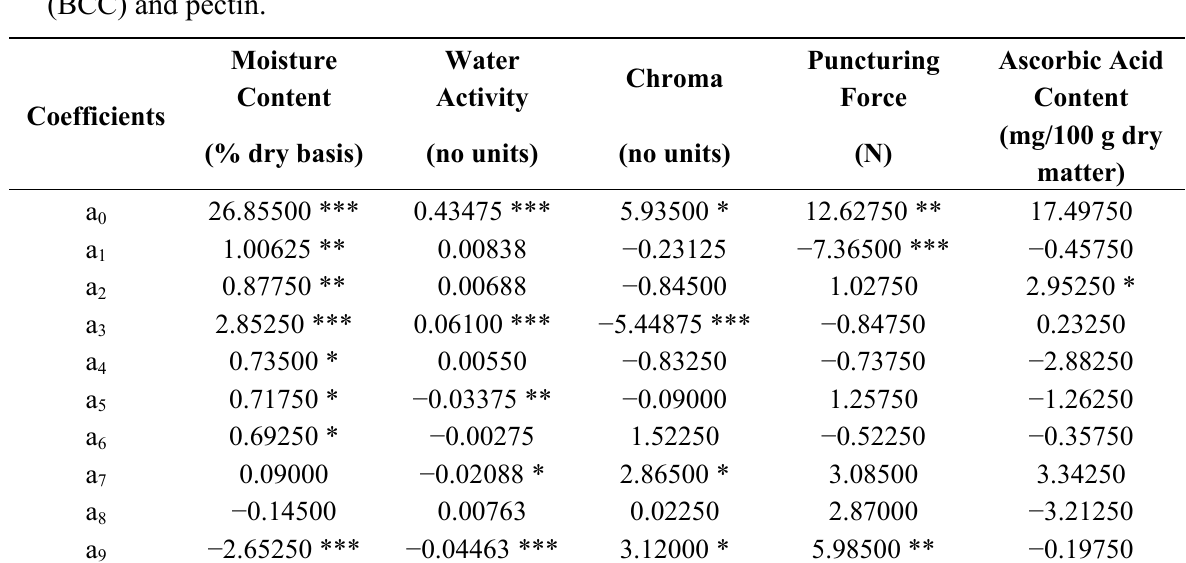
Table 3. Coefficients of the quadratic mathematical model for moisture content, water activity, chroma, puncturing force and ascorbic acid content of apple-blackcurrant fruit leather using different levels of apple juice concentrate (AJC), blackcurrant concentrate (BCC) and